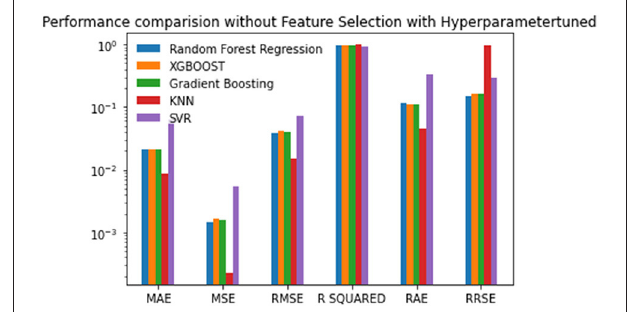
FIGURE 5 | Performance comparison graph of regression techniques without feature selection and with hyperparameter tuning.